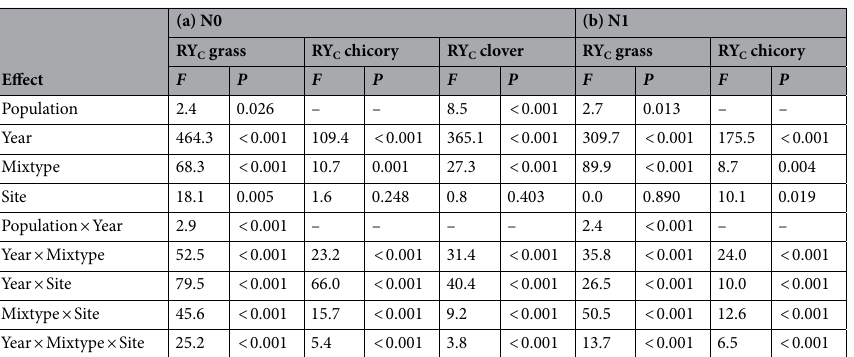
Table 2. Effect of white clover population, experimental year, mixture type and study site on corrected relative yields (RY C ) of grass, chicory and clover using ( a ) unfertilized (N0) and ( b ) fertilized (N1) non-leguminous reference stands. F - and P -values of sequential Wald chi-square tests are given. – Effect not retained in the minimum adequate